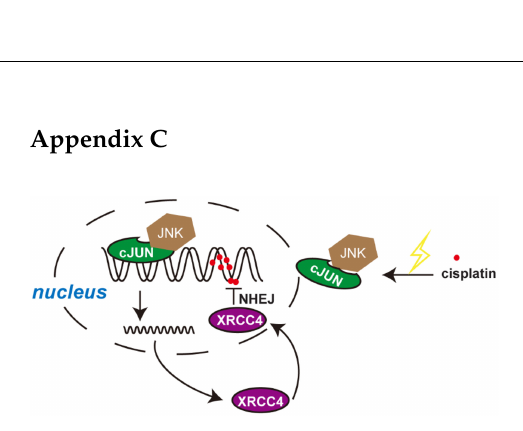
Figure A3. Illustration of working model. Cisplatin treatment induced the activation of the JNK-cJUN axis, which translocated to the nucleus and drive the transcription of XRCC4. XRCC4 contributes to DNA repair through the NHEJ pathway and therefore promotes cisplatin resistance in ovarian